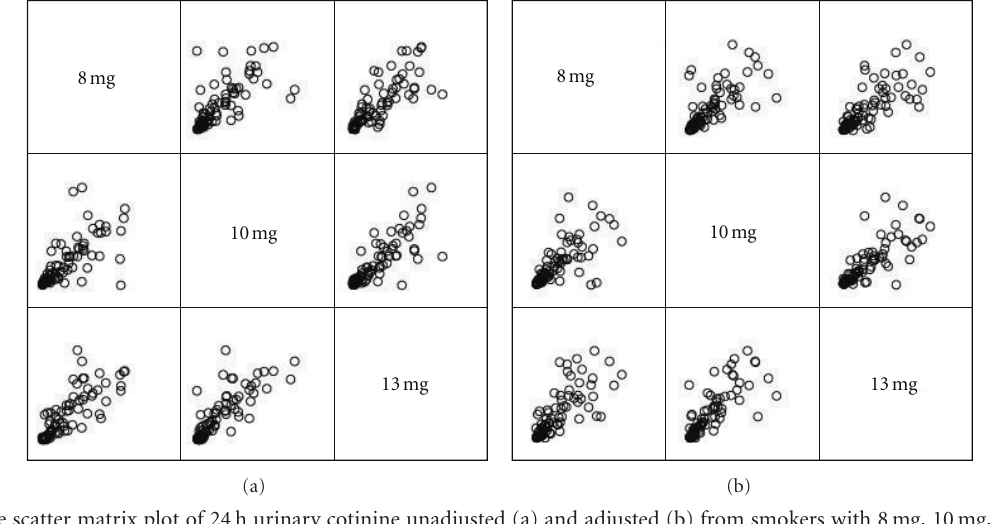
Figure 5: The scatter matrix plot of 24h urinary cotinine unadjusted (a) and adjusted (b) from smokers with 8 mg, 10mg, and 13mg tar yield cigarette. Table 3: Correlation of 24h urinary cotinine unadjusted and adjusted with